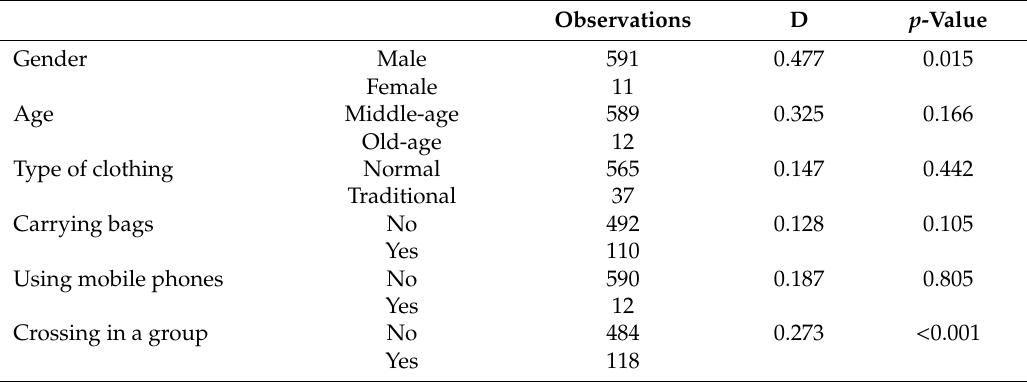
Table 3. Results of Kolmogorov–Smirnov test